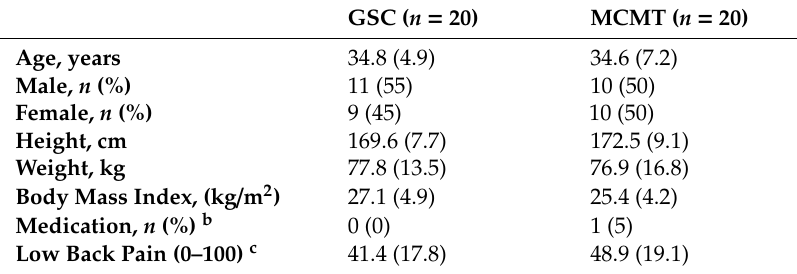
Table 1. Descriptive characteristics of participants at baseline of those randomized to general strength and conditioning (GSC) and motor control manual therapy